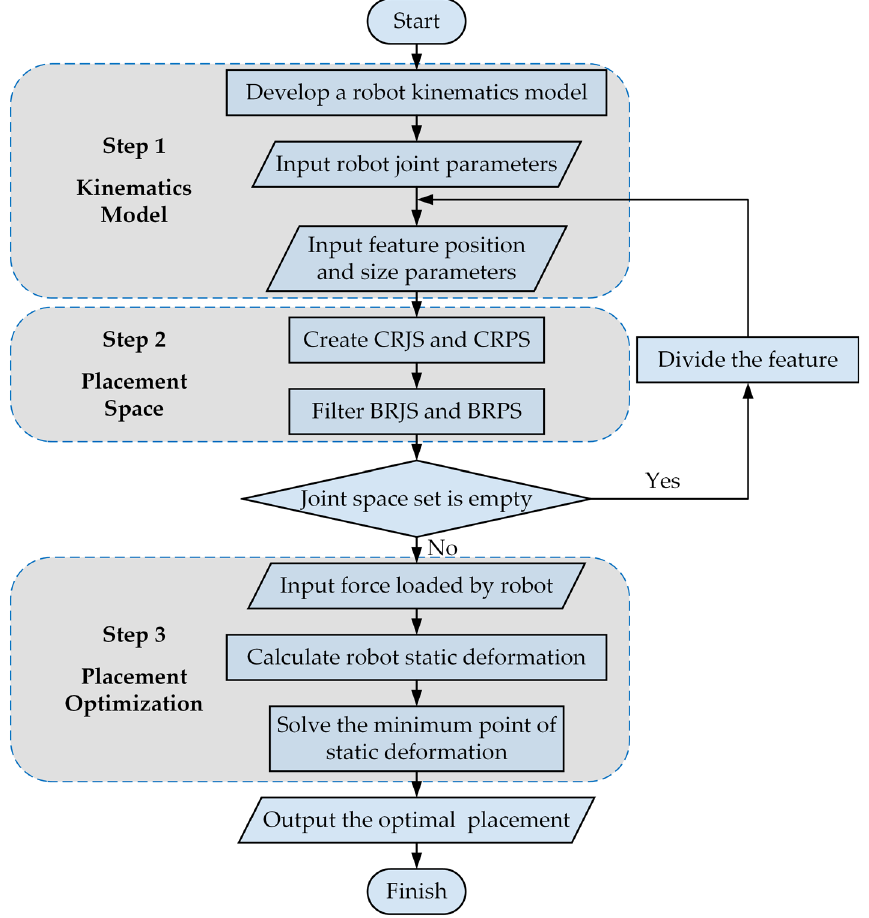
Figure 8. The robot placement planning flow chart.